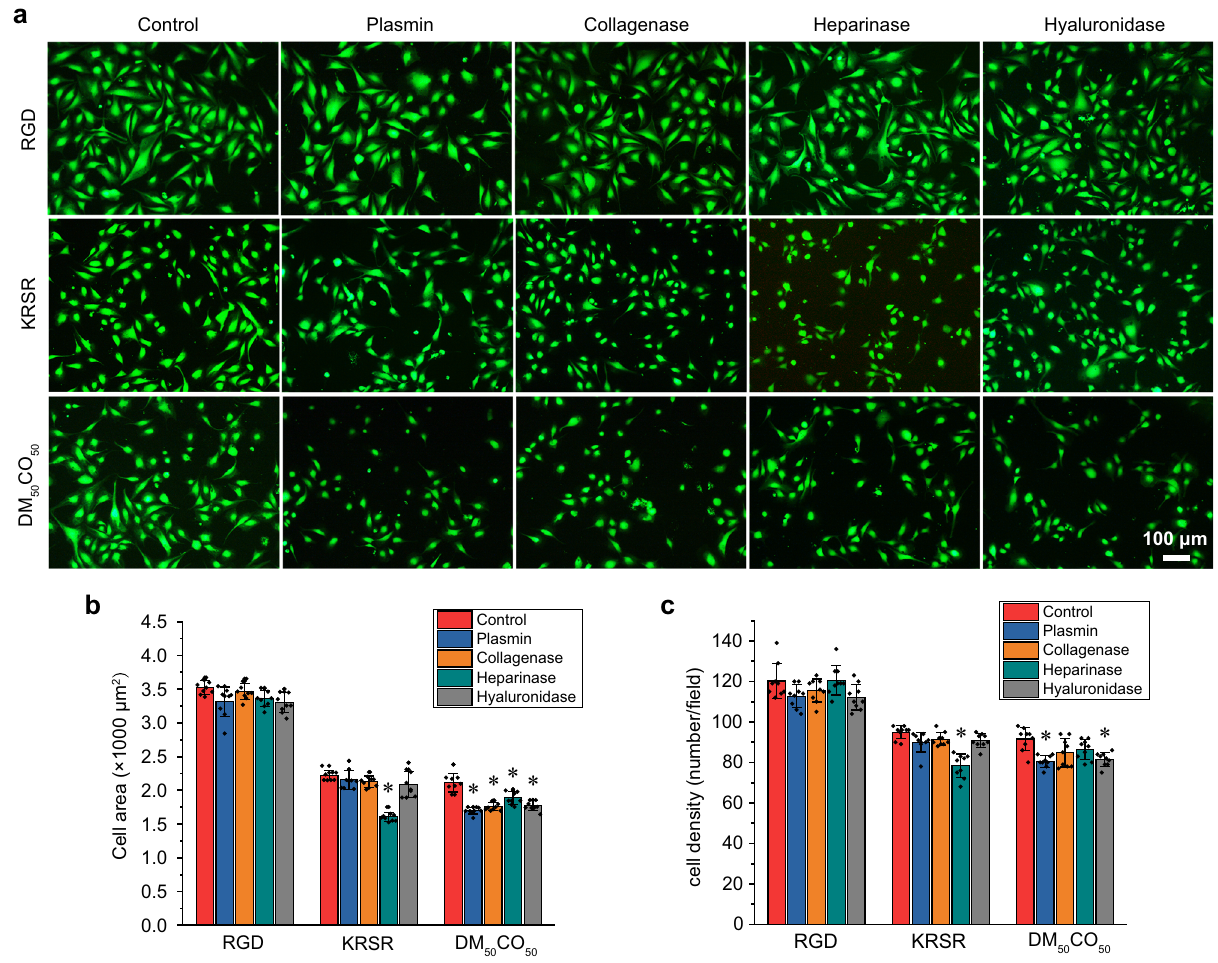
Fig. 6 Effect of membrane proteins and polysaccharides on preosteoblast cell adhesion. Fluorescent micrographs of: a live/dead stained cells, b spreading area, and c density analysis, of cells adhered to RGD, KRSR, and DM 50 CO 50 -modi fi ed surfaces for 1 day in a serum-free medium. Cells were treated with plasmin, collagenase, heparinase, and hyaluronidase, respectively, before seeded on the surfaces. Untreated cells were used as the control. Data in ( b , c ) represent mean ± s.d. ( n = 9). Statistical analysis: one-way ANOVA with Tukey post-test, * p <